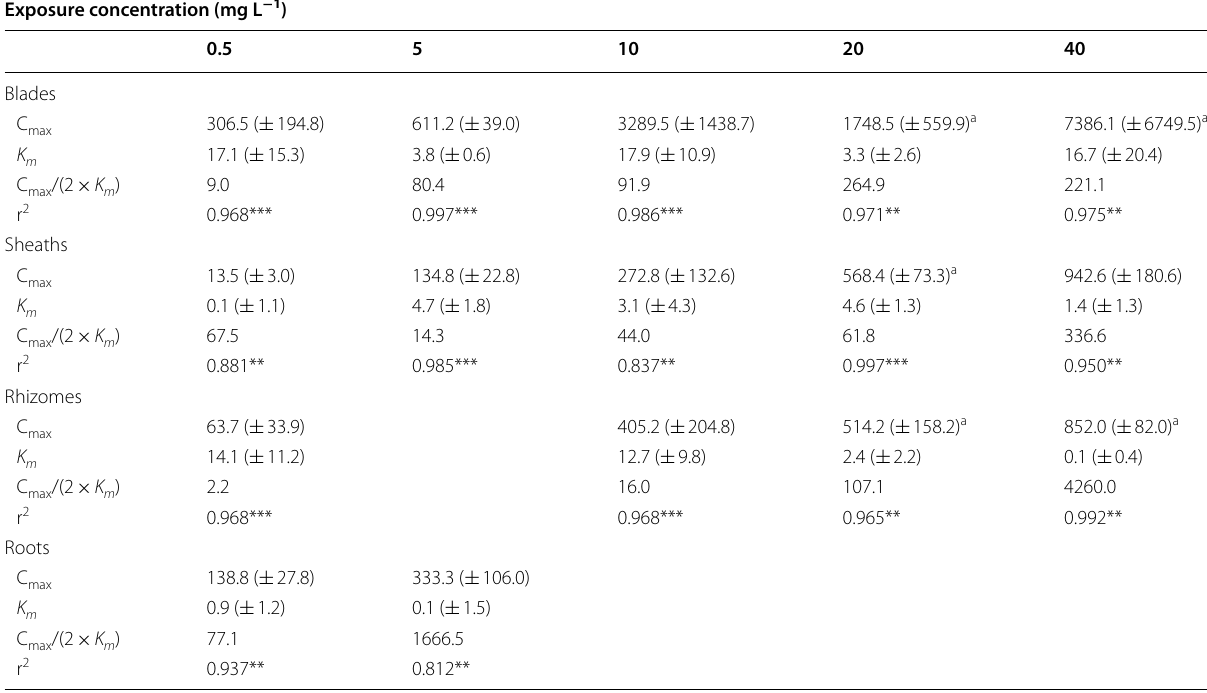
Table 2 Kinetics of cadmium accumulation in parts of Cymodocea nodosa exposed to different concentrations of cad- mium in